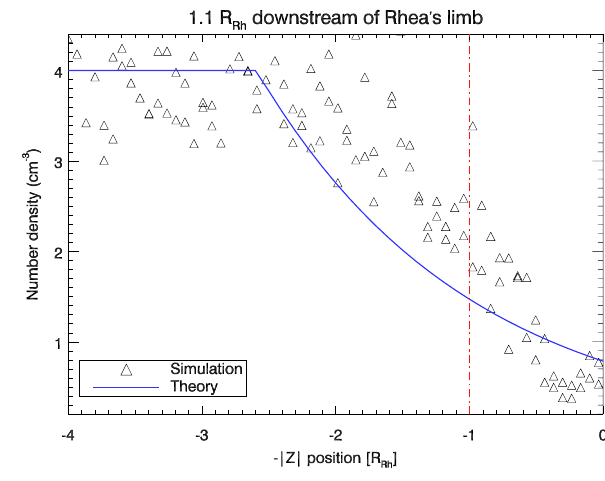
Fig. 2. Illustation of Eqs. (7). The position up to which the rarefac- tion wave has propagated is given by − (C s t + 1 ) . The dependence of the solution from the sound speed, tells us that the wake structure in the xz plane is determined by the plasma temperature. We note that in most previous studies the wake boundary is set at z =0 and the limb location at x limb =0, which results in a slightly different form of Eqs. (7). Since we want to in compliance with our simulation co- ordinate system, this slight modification in the equations has been introduced.